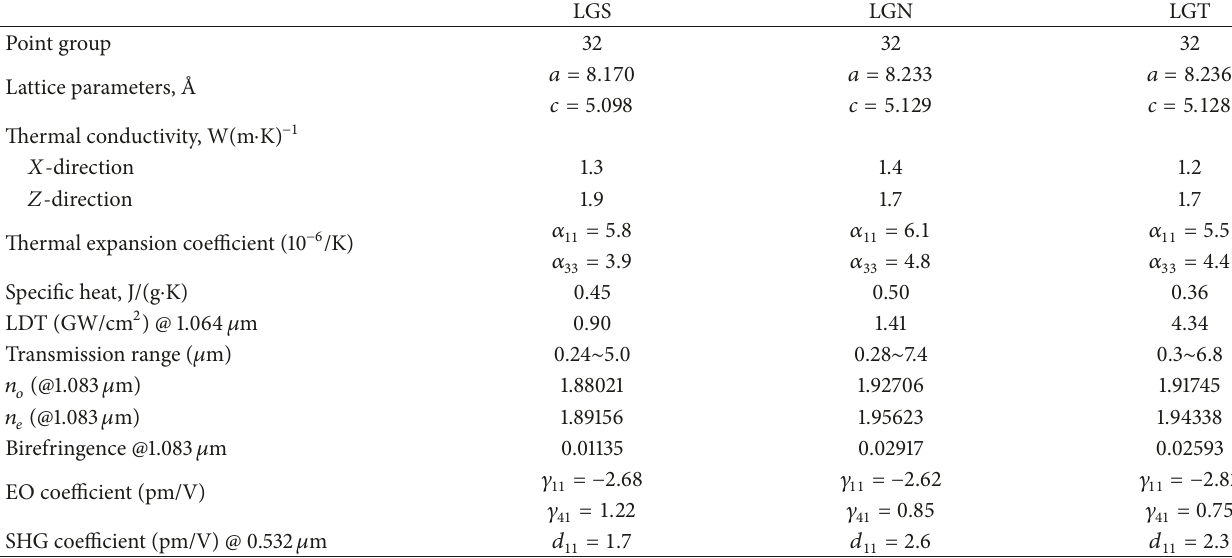
Table 2: Comparison of the physical parameters of the LGS, LGN, and